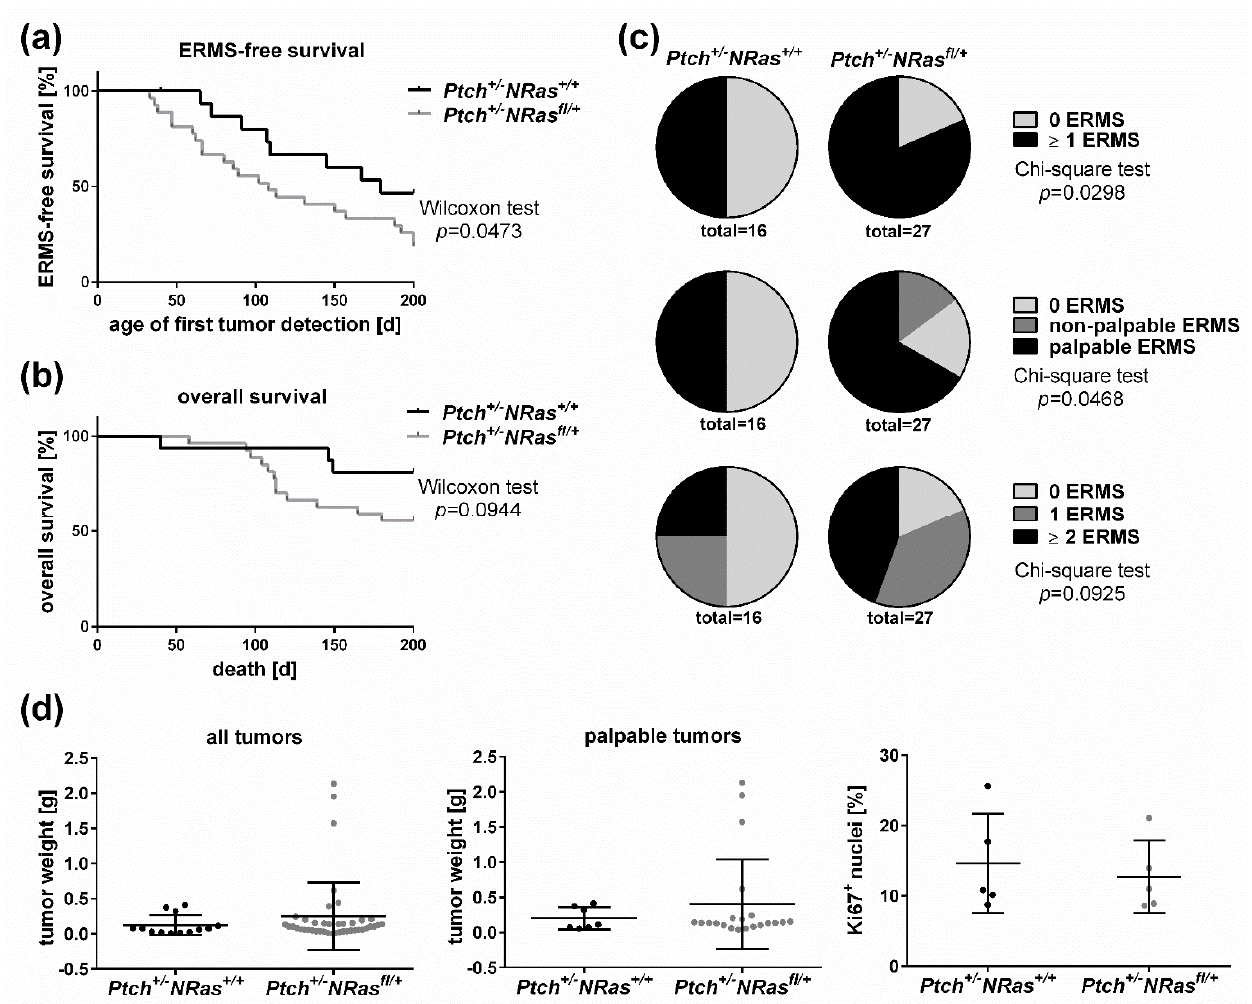
Figure 1. Progression of ERMS precursor lesions upon oncNRAS expression in 2-week-old mice. ERMS development in Ptch +/- NRas fl/+ Myf5 CreER/wt ( Ptch +/- NRas fl/+ ) and Ptch +/- NRas +/+ Myf5 CreER/wt ( Ptch +/- NRas +/+ ) mice injected with tamoxifen at 2 weeks old. ( a ) ERMS-free survival, ( b ) overall survival of the animals, ( c ) ERMS incidence of mice that ever developed an ERMS (top), incidence of palpable and non-palpable ERMS (middle) and of ERMS multiplicity (bottom) and ( d ) tumor weight of all (right) and of palpable ERMS (middle) and percentage of Ki67 + nuclei in ERMS tissue sections (left). Numbers of animals and tumors included in the experiments are given in Table 1. Each dot in ( d ) represents an individual tumor. For determination of the Ki67-index, all Ki67 + and Ki67 neg nuclei in 6 sections of 5 different ERMS per genotype were determined. Bars: mean ± SD. Statistical evaluation was conducted with Gehan–Breslow–Wilcoxon testing in ( a , c ), Chi-square testing in ( c ) and Mann–Whitney testing in ( d ).